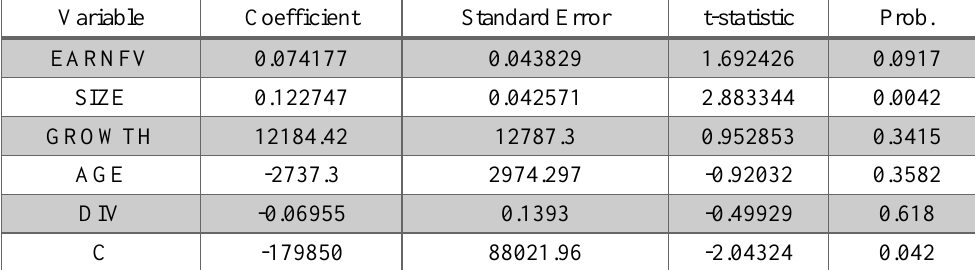
Table 7 . Results of fixed effects- Model Number 3